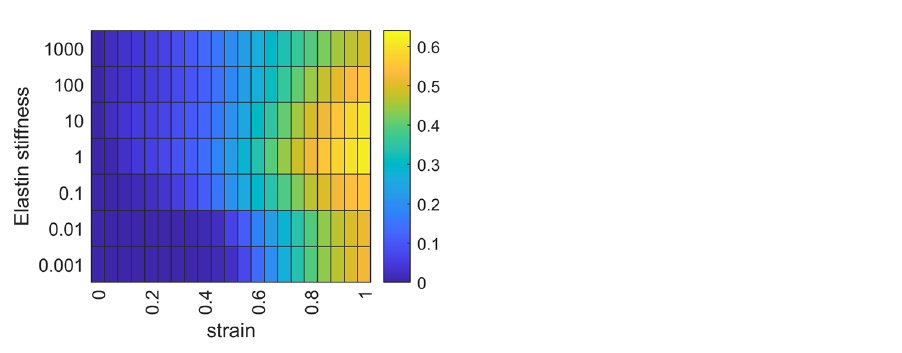
Figure 4. Collagen recruitment fraction (indicated by color according to the color bar at the right) as a function of variation in elastin stiffness relative to its baseline value of 1 (vertical axis) and strain (horizontal axis). At 1000, elastin is as stiff as the stiffest collagen fibers. These results represent the average of 40 independent runs of the model at each value of elastin stiffness.